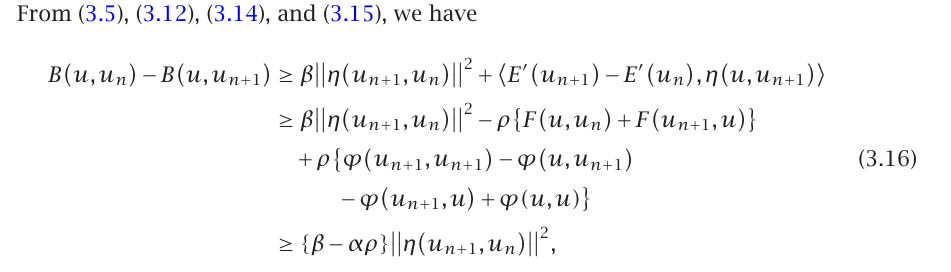
∈ H , find the approximate solution u n + 0